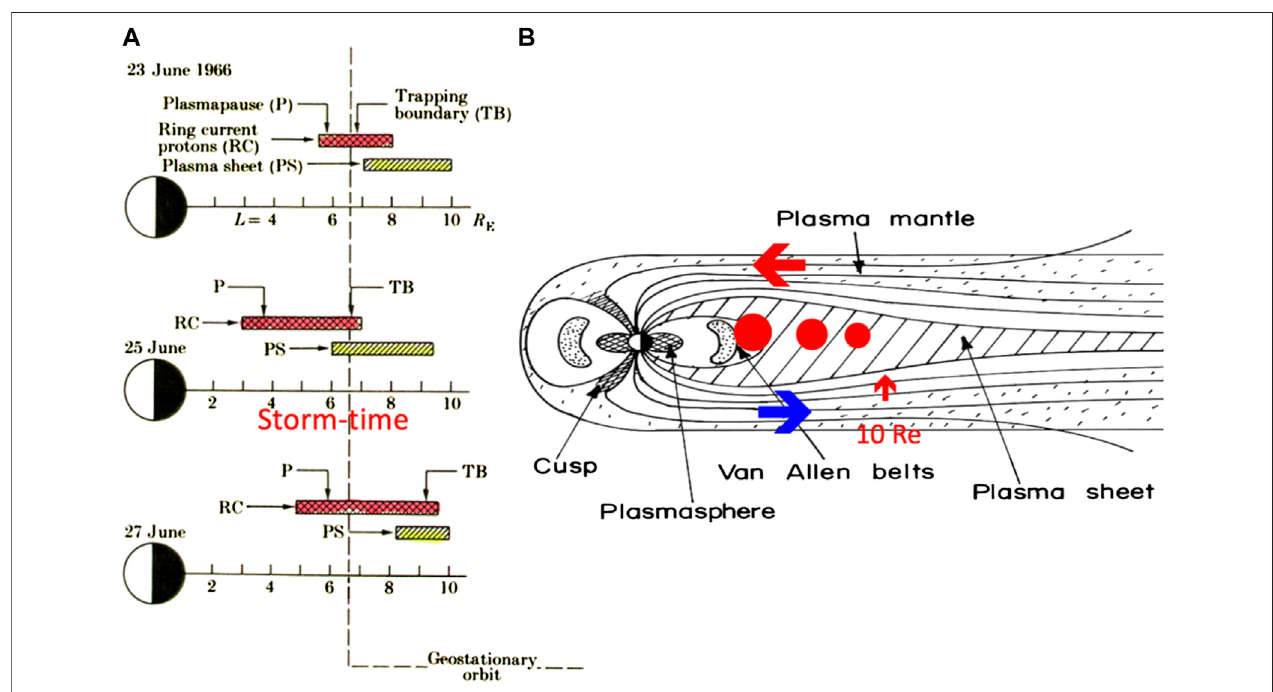
FIGURE 15 | (A) The advance and recede of the ring current belt during a geomagnetic storm (Frank, 1971). (B) Schematic illustration of the advance (red arrow) and retreat (blue arrow) of the ring current belt during geomagnetic storms.